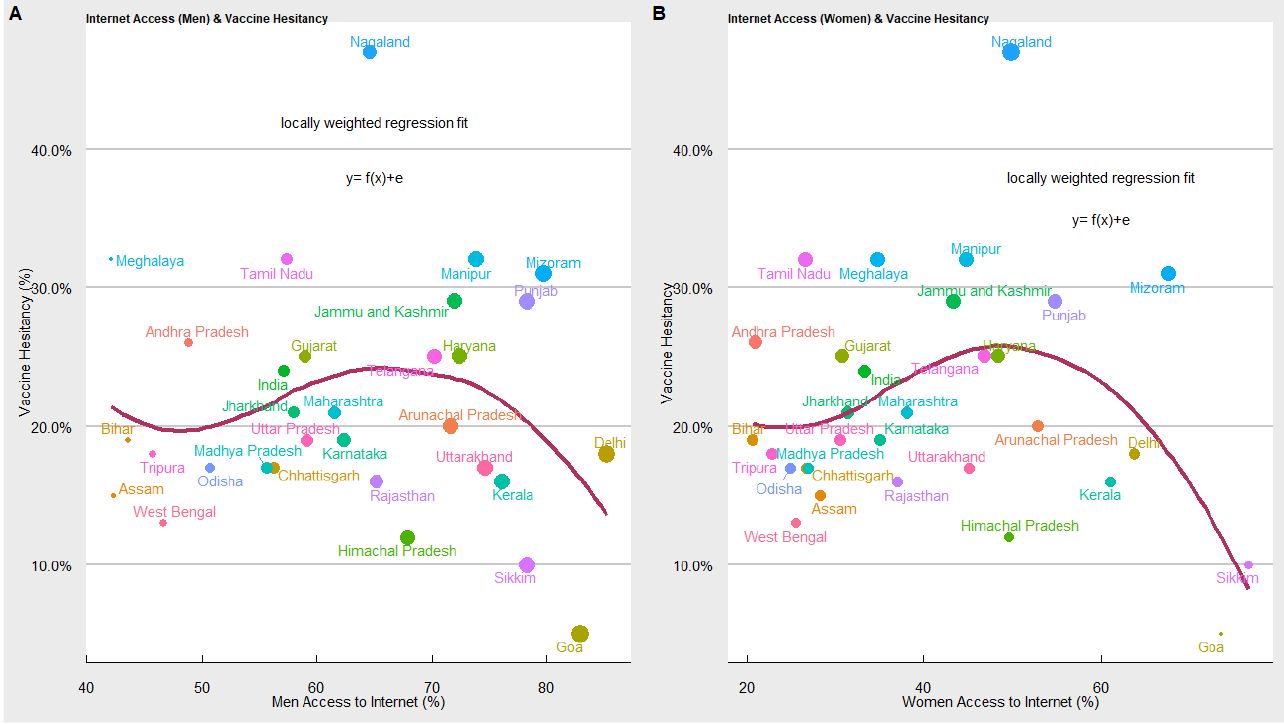
Figure 9. Results of vaccine hesitancy and access to the internet.